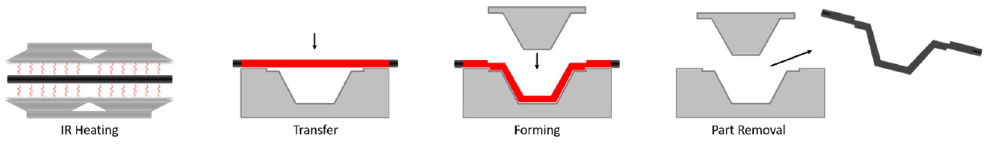
Figure 1. Schematic illustration of the thermoforming process.